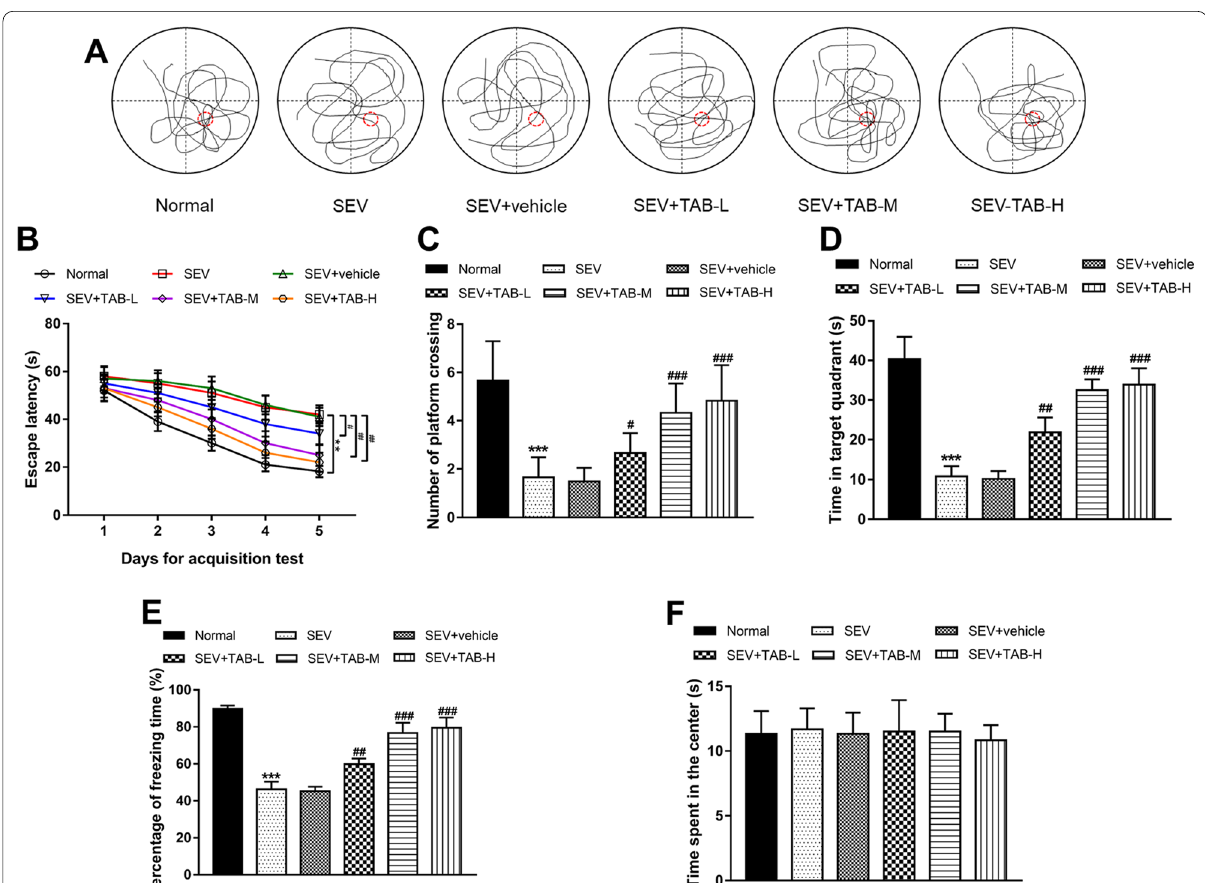
Fig. 1 TAB alleviated the cognitive function of rats exposed to sevoflurane. A The representative trajectories of the rats in the probe trial from the MWM test. B Sevoflurane inhalation led to longer escape latency time, while TAB reduced this time in rats. B TAB administration increased the number of platform crossing, which was reduced by sevoflurane. C The time in target quadrant of rats was shorter in sevoflurane inhalation group than the normal group, but it was promoted by TAB administration. E The freezing time in FCT test was reduced in rats exposed to sevoflurane, and this effect was reversed by TAB treatment. F Time spent in the center of PFT test revealed that sevoflurane and TAB had no significant effects on the behavior of rats. ** P < 0.01, *** P < 0.001 compared to normal group; # P < 0.05, ## P < 0.01, ### P < 0.001 compared to SEV